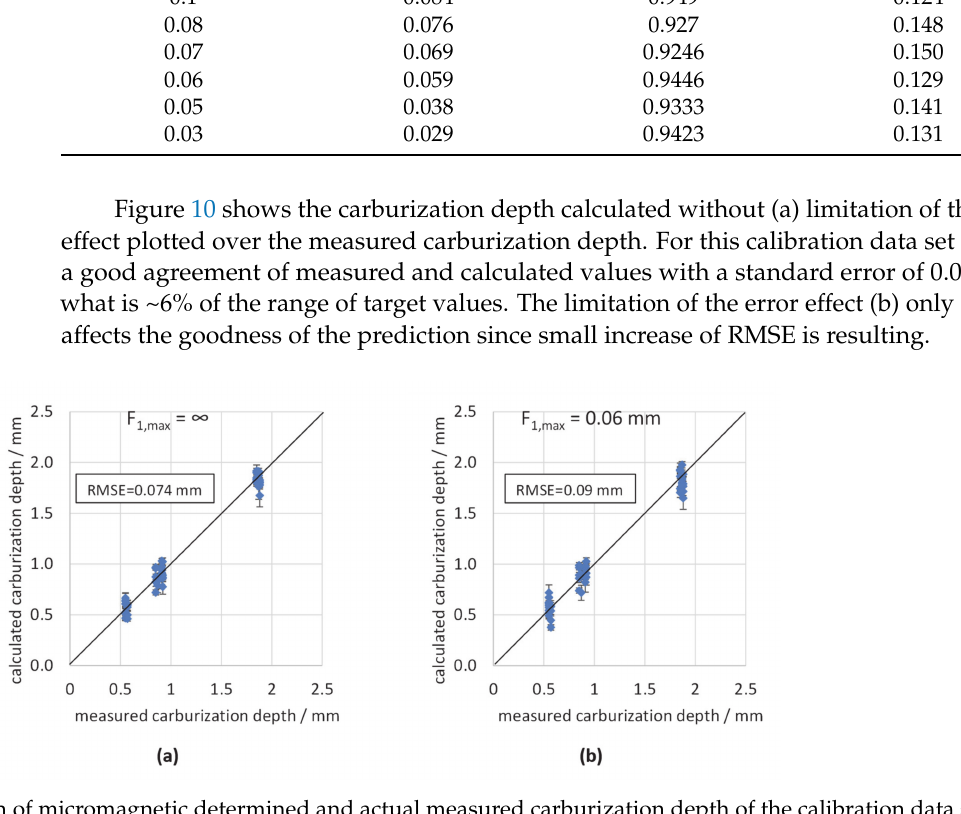
Figure 10. Correlation of micromagnetic determined and actual measured carburization depth of the calibration data set without limitation of the maximum error effect ( a ) and with limitation to 0.06 mm ( b